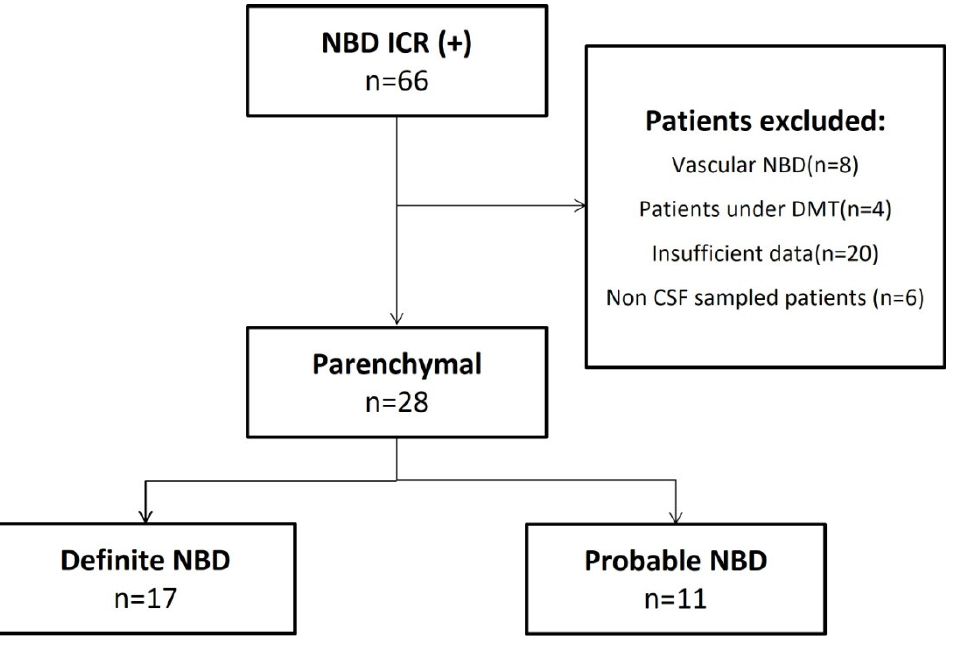
Figure 1. Flow chart depicting patient selection and grouping. DMT: disease-modifying therapy; CSF: cerebrospinal fluid; ISG: International Study Group.